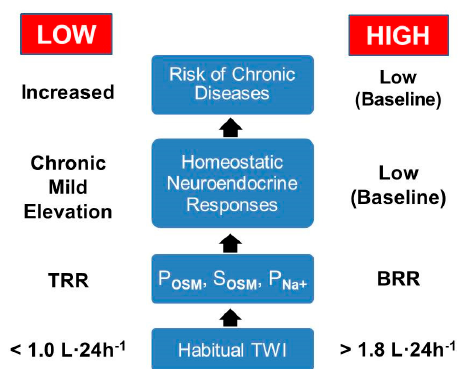
Figure 5. Proposed series of events that lead to the differential risk of chronic diseases in LOW and HIGH. Homeostatic neuroendocrine responses include increased plasma AVP and cortisol in LOW (see section 5 above). Abbreviations: TRR, top half of the laboratory reference range; BRR, bottom half of the laboratory reference range [42]. This paradigm is based on eight source publications